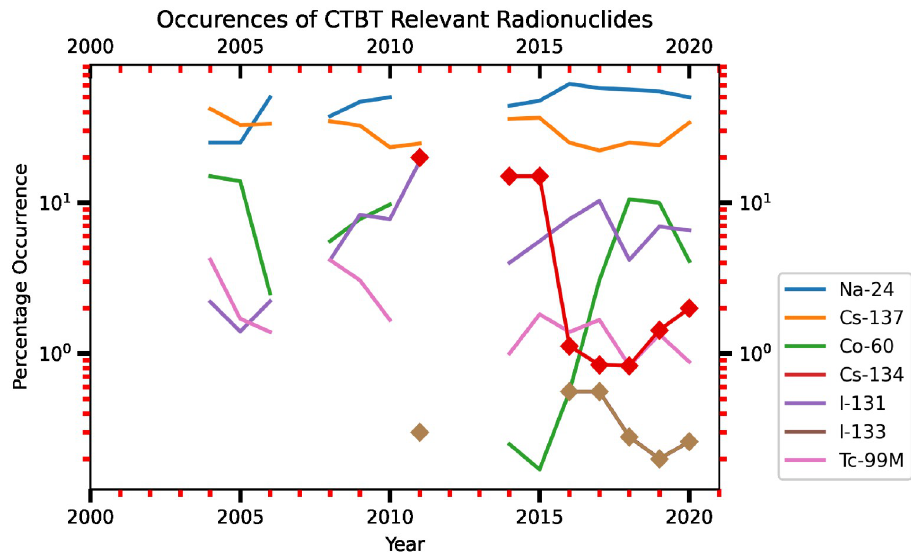
Fig 19. Annual percentage occurrences of the CTBT-relevant radionuclides during the period